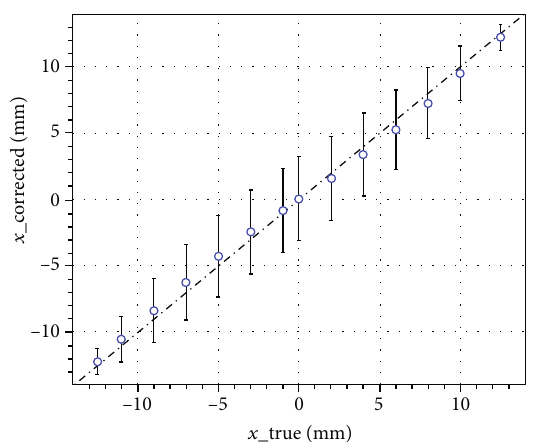
Þ in the corrected Þ . true